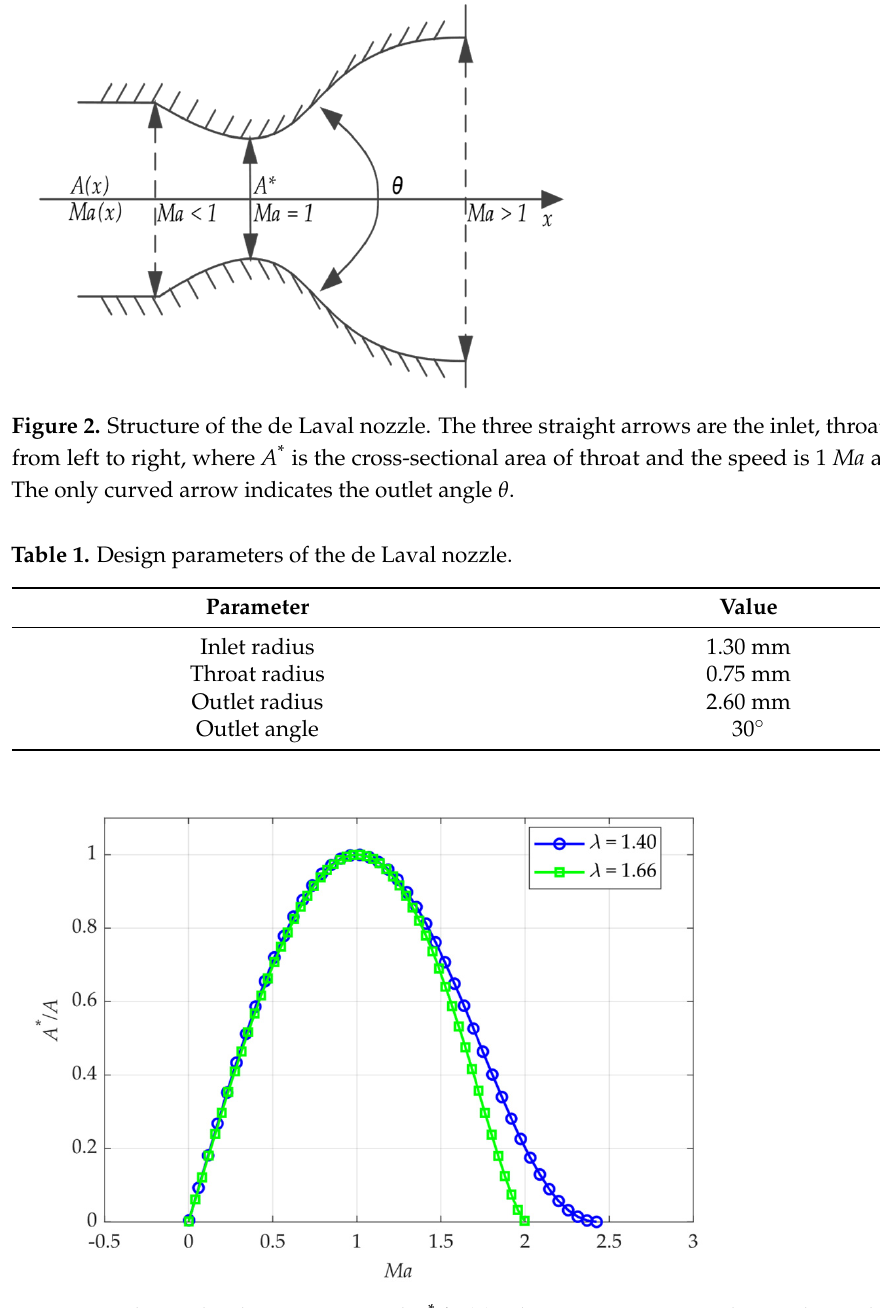
Figure 3. Relationship between Ma and A * / A(x) . The x-axis represents the Mach number, which is the ratio of the jet speed to the local speed of sound (the blue line intersects the x-axis at 6 , and